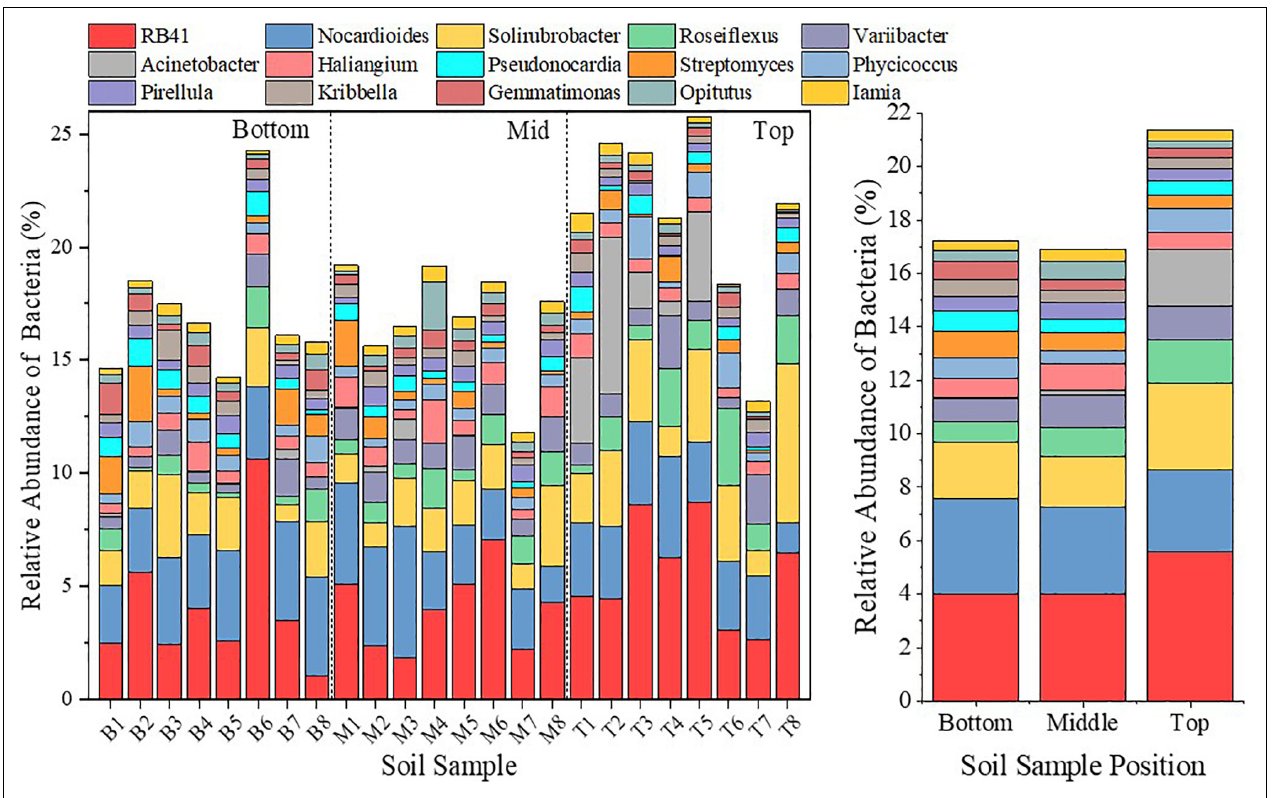
FIGURE 10 | Bar diagram to represent the bacterial community analysis on the genus level at different locations of the subsidence